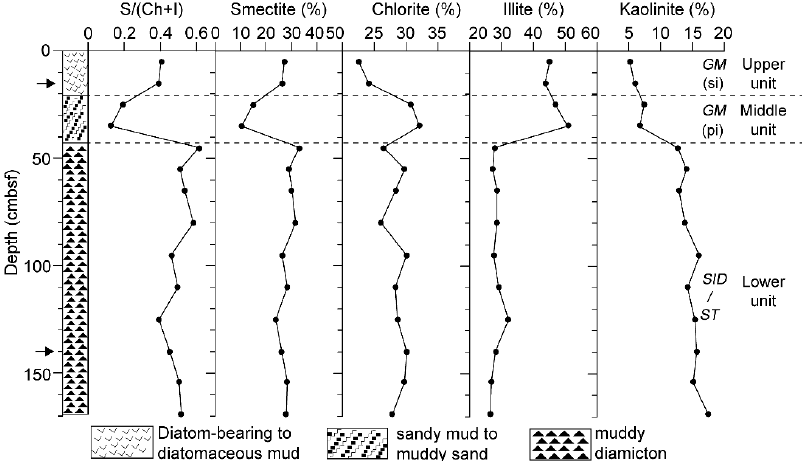
Figure 3. Sedimentary facies (three distinct units from glacimarine sediment to proximal sub-ice shelf diamicton/soft till), contents of smectite, chlorite, illite, and kaolinite in core GC360. (GM: glacimarine sediment, ST: soft till, SID: proximal sub-ice shelf diamicton, si: seasonal sea-ice cover, pi: permanent sea-ice cover/distal ice-shelf cover) (Modified from Hillenbrand et al., 2009 [10]). Arrow indicates the depth of transmission electron microscopy (TEM) samples.